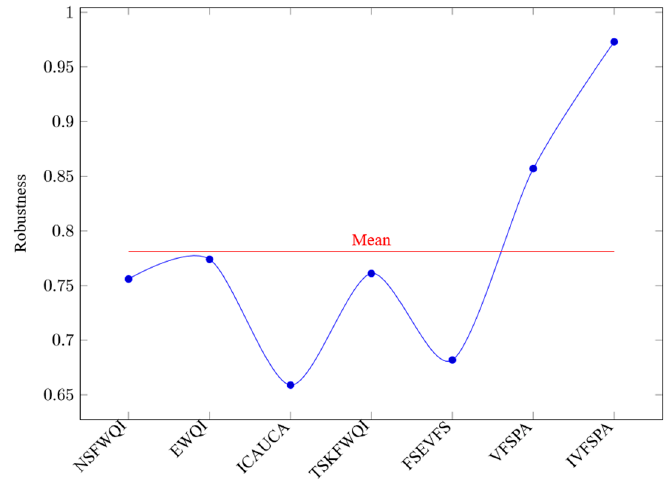
Figure 7. Robustness values.